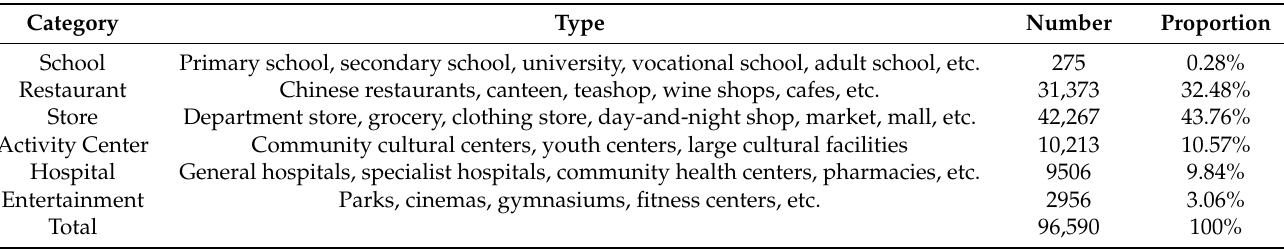
Table 1. Summary of Point of Interest